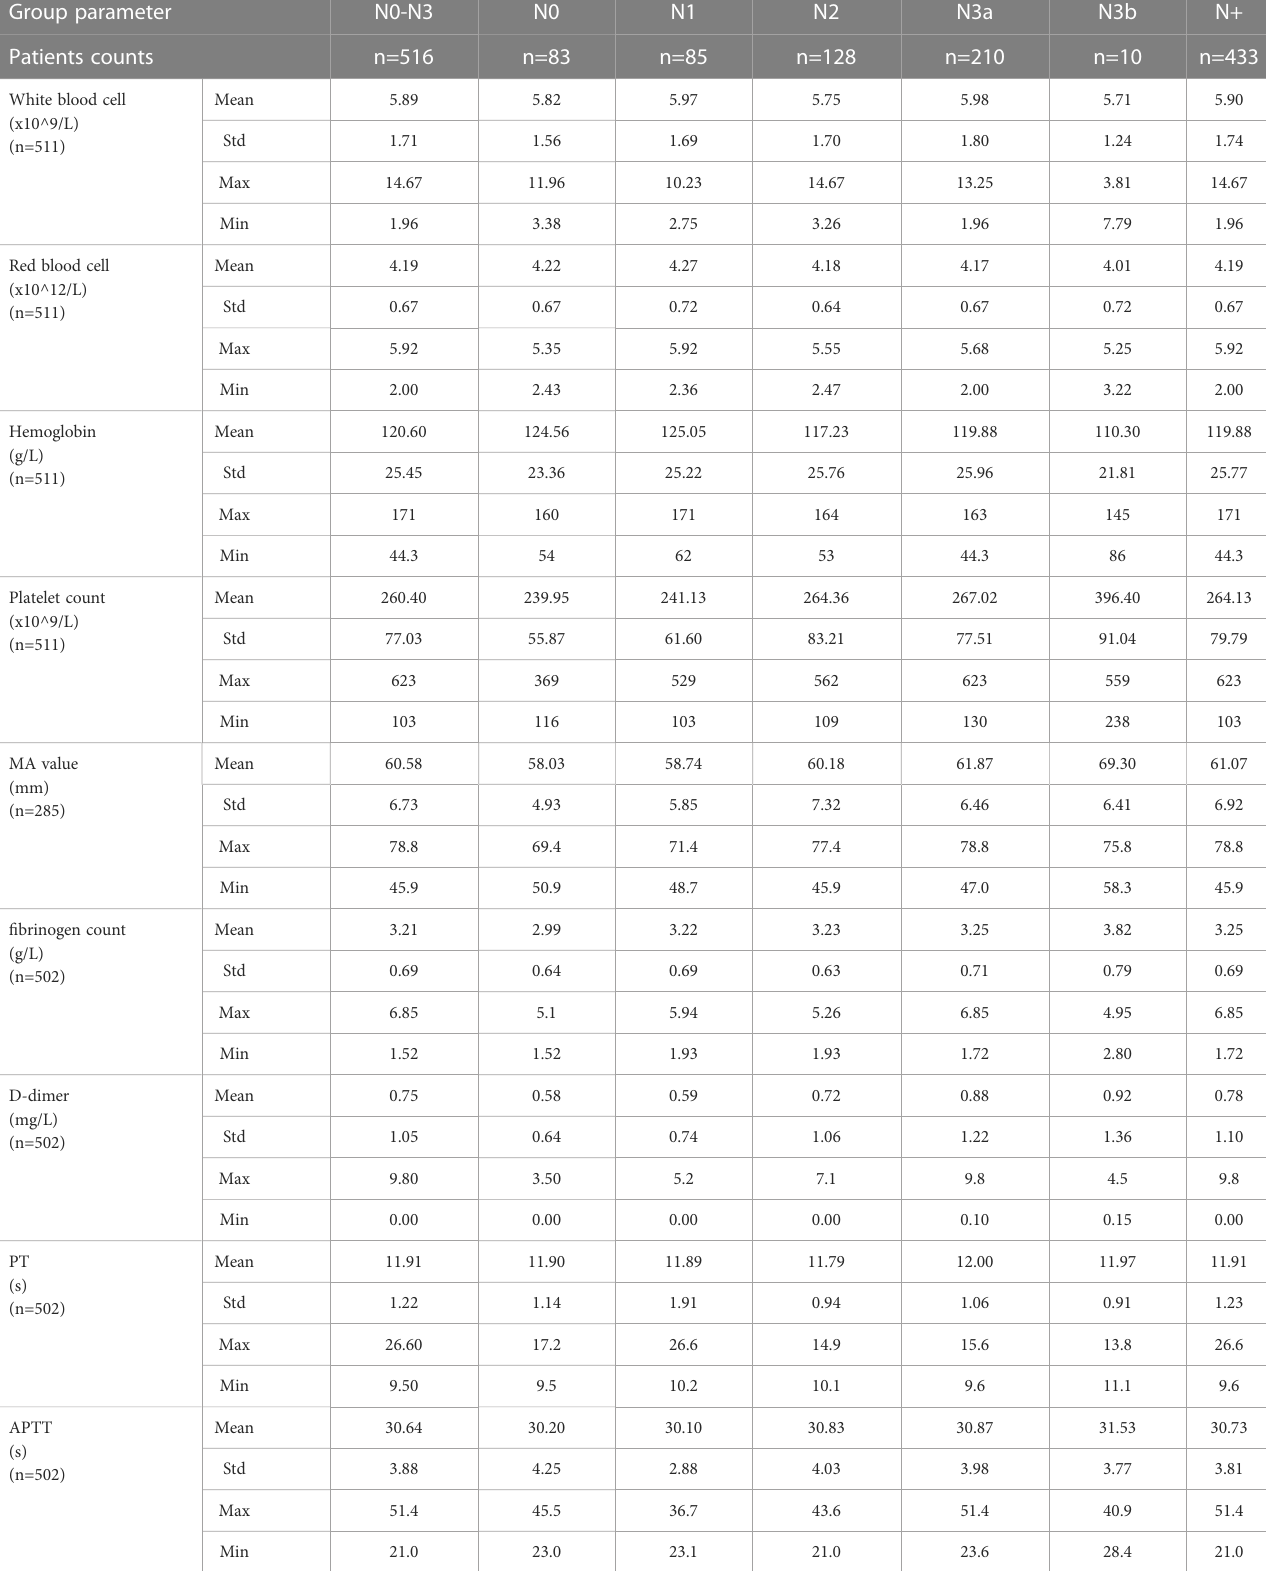
TABLE 2 Basic statistic data of laboratory examinations for the clinical participants. Group parameter Patients